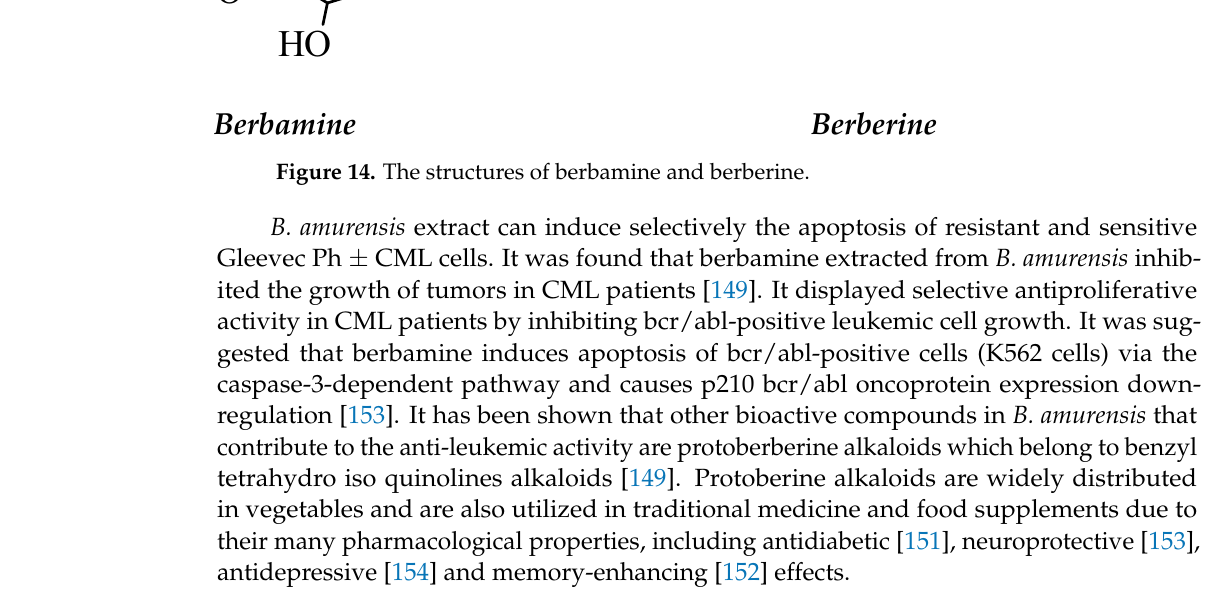
Figure 15. The structures of baicalein and wogonin.